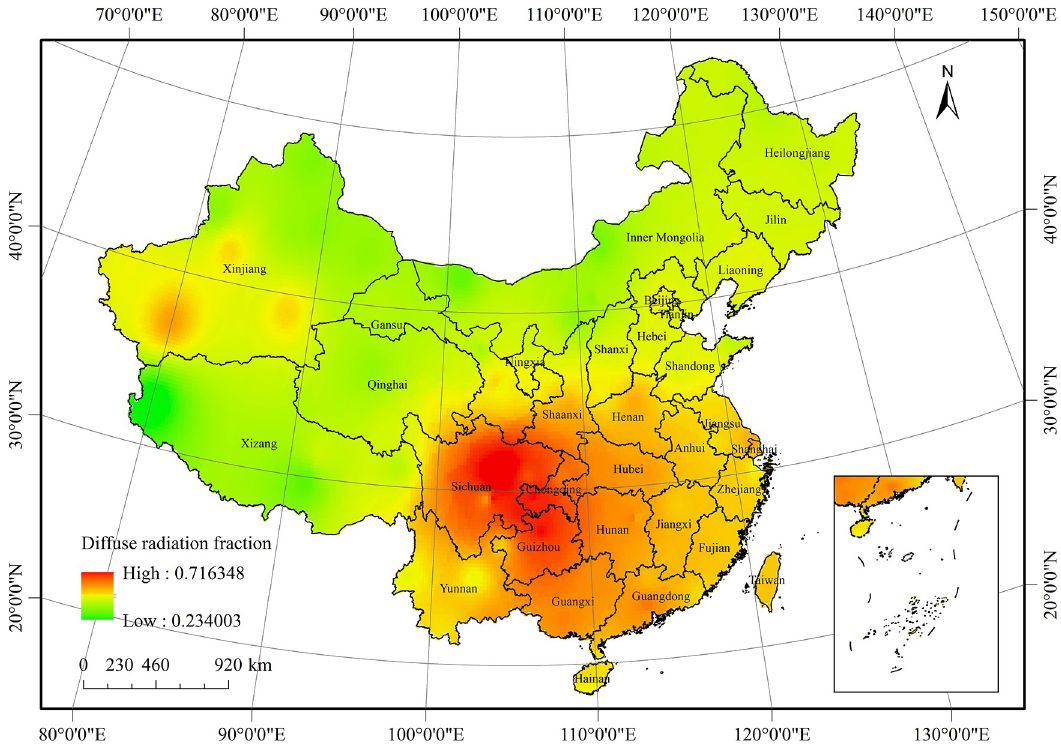
Fig 7. Average distribution of diffuse radiation fraction in China from 1961 to